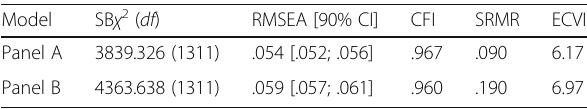
Table 3 Fit indices of the two alternative mediation models